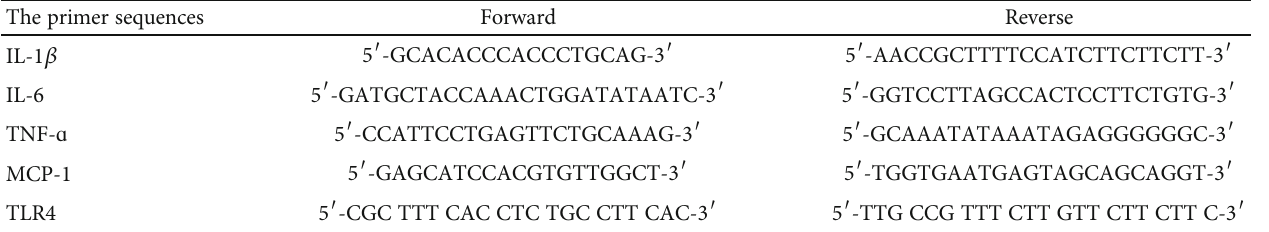
Table 1: The primer sequence for